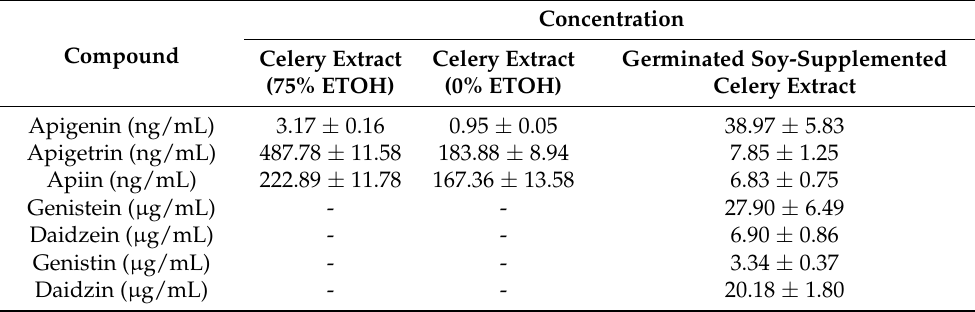
Table 4. Key bioactive compounds in celery and soy obtained under optimal conditions in apigetrin- optimised celery extracts and germinated soy-supplemented celery